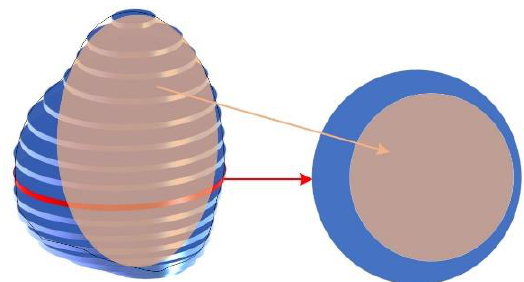
Figure 12. Largest possible ellipse, whose volume is limited by region of pellet, is drawn inside of a pellet.